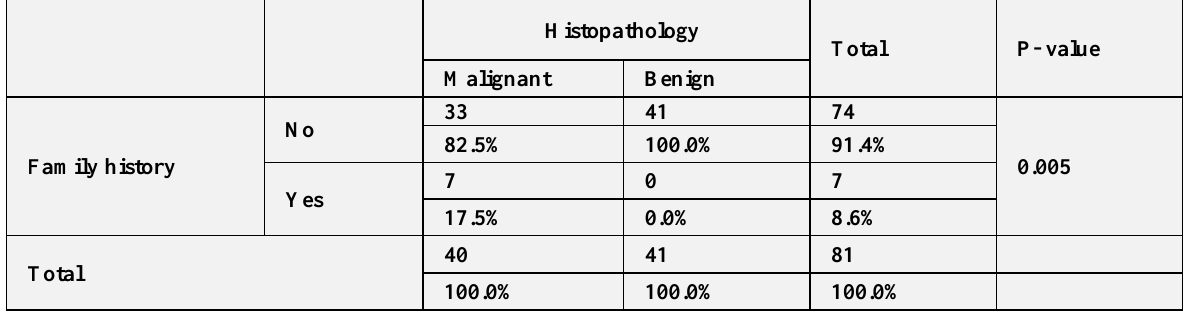
Table (3):Association between family history and histopathological findings.